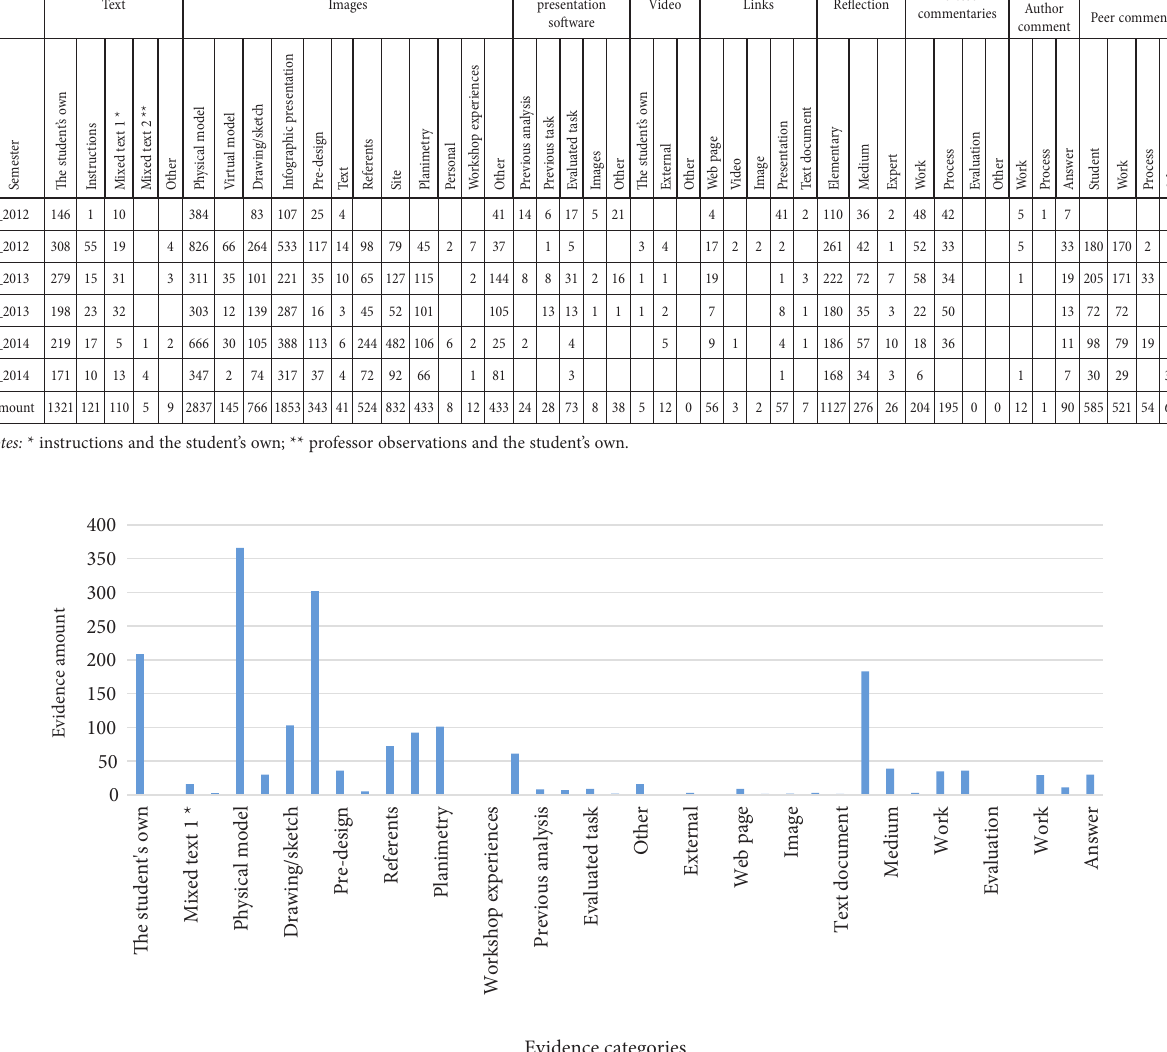
Online presentation Video Links Reflection Professor commentaries software